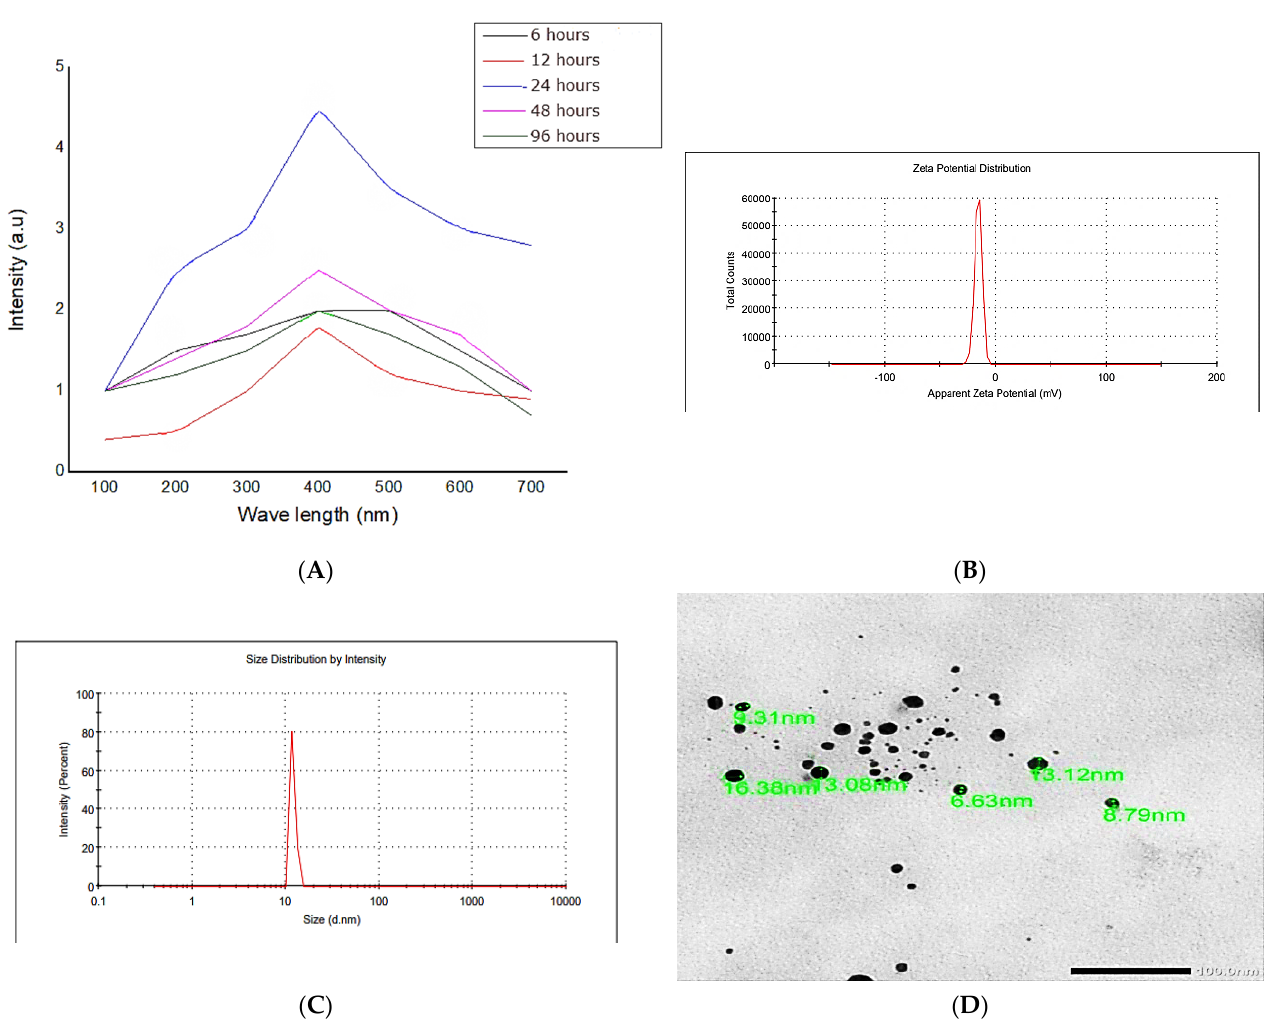
Figure 2. UV-Visible absorbance ( A ), Zeta potential ( B ), Zeta size distribution ( C ), and TEM micrograph ( D ) of the biosynthesized AgNPs using the snails’ mucus extracts.